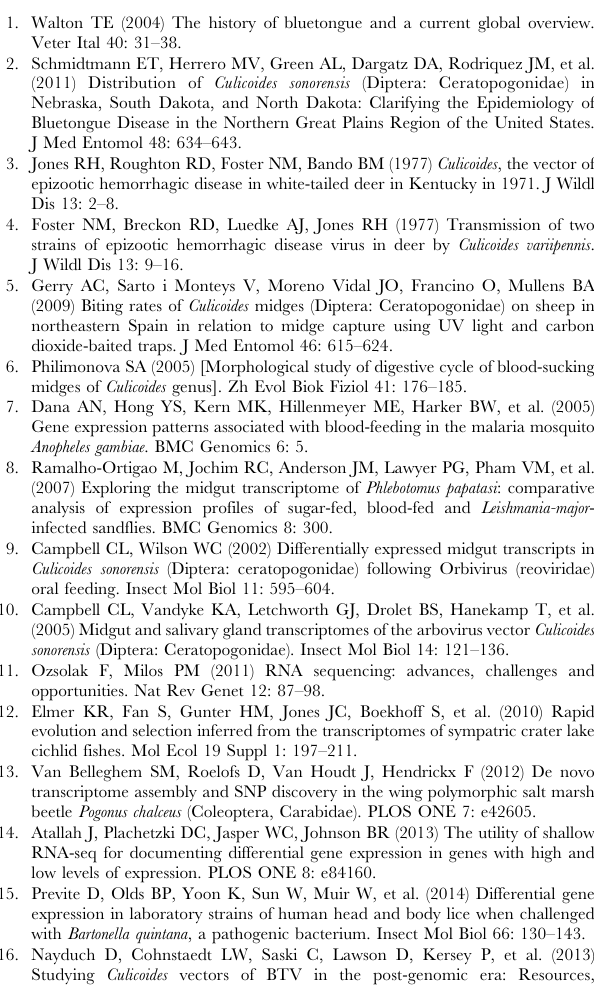
C. sonorensis . Table S7. Significant differentially expressed genes between teneral and late blood-fed C. sonorensis . Table S8. Significant differentially expressed genes between early and late blood-fed C. sonorensis . Table S9. Significant differentially expressed genes between teneral and early sugar-fed C. sonorensis . Table S10. Significant differentially expressed genes between teneral and late sugar-fed C. sonorensis . Table S11. Effect of sucrose feeding on differential expression of genes in female Culicoides sonorensis . Table S12. Differential expression of putative house- keeping or reference genes in C. sonorensis